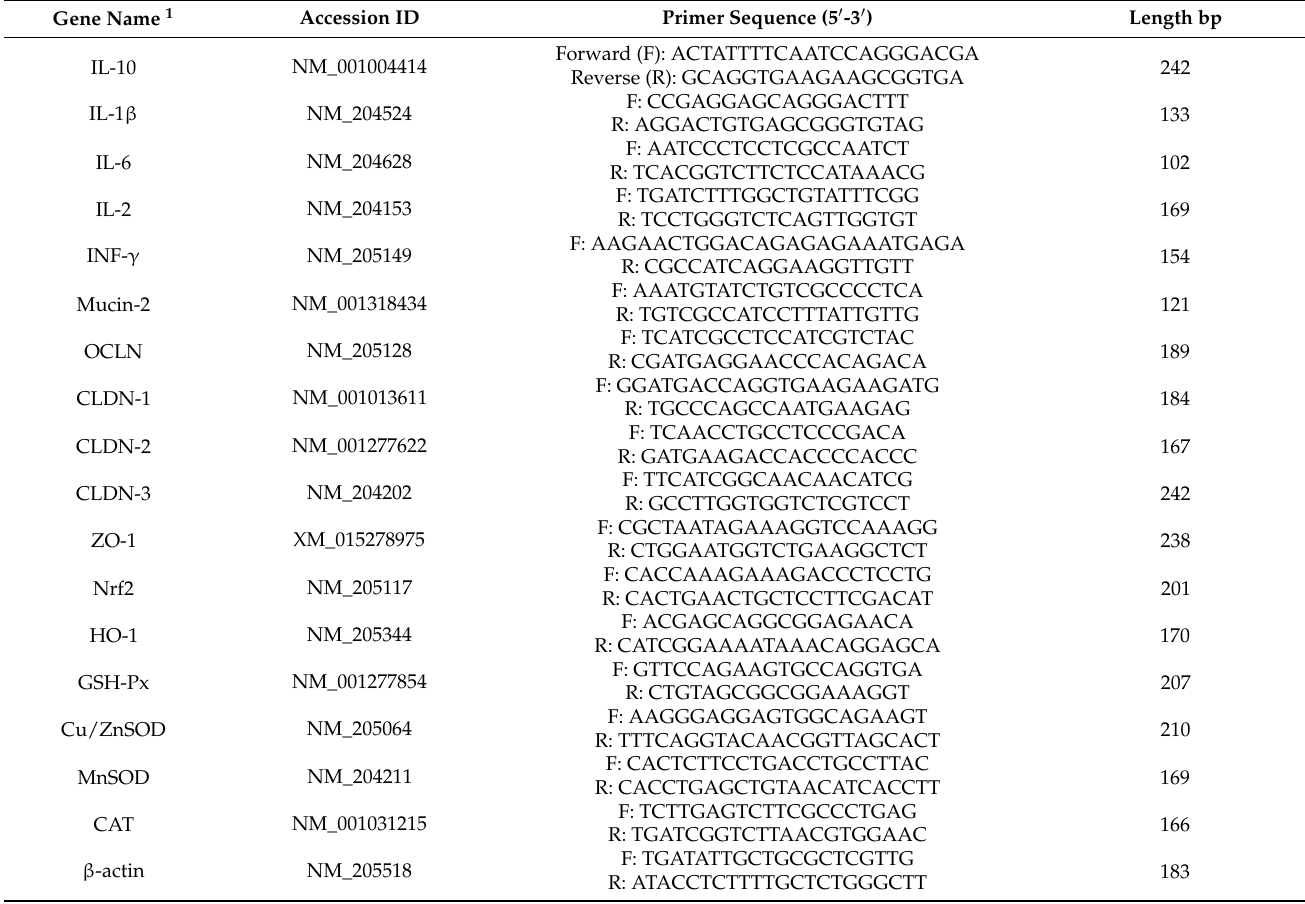
Table 2. Primer sequences for quantitative real time PCR